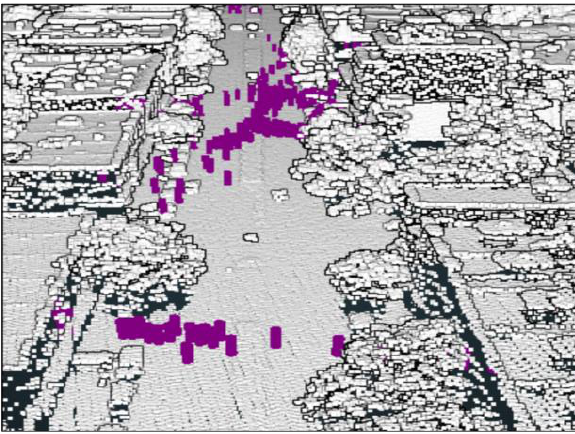
Figure 4. Univariate 3D scene visualization depicting individual egress behavior at a single healthcare facility